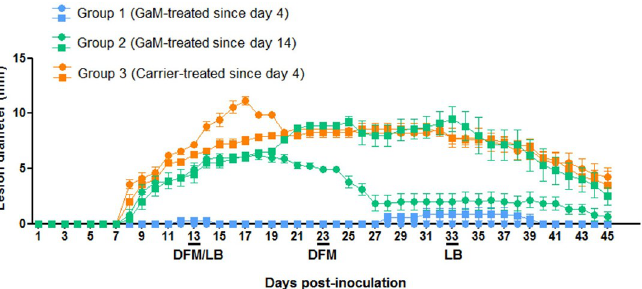
Fig 2. Measurement of lesion diameter in treated and control rabbits. Lesion diameter (mm) was measured starting 24 hours post-inoculation (day 1) up to day 45. Group 1 rabbits (n = 2, blue) were treated since day 4 post-inoculation, while Group 2 animals (n = 2, green) were treated since day 14. Control animals (orange) received only carrier (an emulsion of water and hydrophilic petrolatum) since day 4 post-inoculation. Days 13 and 23 are underlined to indicate the days on which DFM of lesion aspirates was performed and/or lesion biopsies (LB) were obtained. Within in each group, the lesion diameter from each individual rabbit is designated with a dot or square.